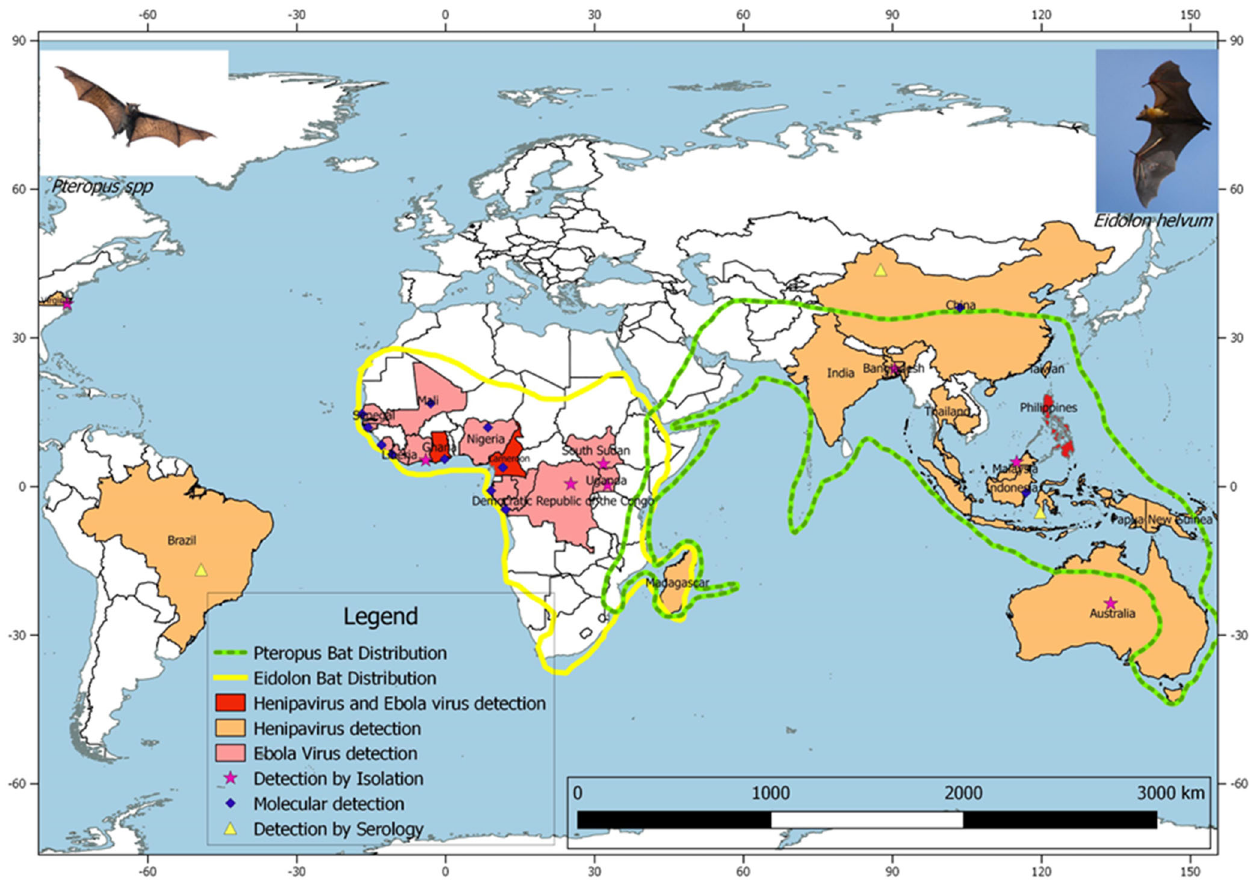
Fig. 1 Map showing the detection of Henipavirus and Ebola virus, and the distribution of their most likely reservoir host — the Pteropus and Eidolon bat genera. The green dotted line shows the distribution of Pteropus bats while the continuous yellow line shows distribution of the Eidolon bat species. Determination of the virus distribution is by detection of Viral RNA or antibodies against the viruses. The orange shade indicates countries where Henipavirus outbreaks have been recorded or henipaviruses detected in bats, while the pink shade indicates outbreaks or detection of Ebola virus. The red shade shows detection and/or outbreaks for both Ebola and different ratios of expression plasmid DNA for NiV M, F, G (Malaysia strain), HeV F, G (original Australian strain), and EBOV GP (Zaire strain), for a total of 30 µg of plasmid DNA per 15-cm dish (Fig. 2A). Incorporation of proteins onto the VLPs was con fi rmed using standard Western blot analysis. From the initial results of experiments such as that shown in Fig. 2A, we expanded the total µg of DNA used to 45 µg/15-cm dish and tried various DNA ratios (Fig. 2B). Transfection of cells with the DNA ratio 7:12:12:2:2:10 µg for NiV M, NiV F, HeV F, NiV G, HeV G, and EBOV GP, respectively, yielded the best protein incorporation into virions (Fig. 2B) and expression of the proteins in cell lysates (Fig. 2C), determined by fl uorescent Western blot analysis quanti fi cation. Individual protein blots with molecular weight markers for VLPs are shown in supplementary Fig. 11. We also determined the cell surface expression (CSE) levels for each glycoprotein by fl ow cytometry (Fig. 2D). Incorporation of the proteins onto VLPs was determined by fl ow virometry 34 (Fig. 2E). The results demonstrated that multiple glycoproteins can be found on the surfaces of viral particles of a single viral preparation. We demonstrated the presence and distribution of the glycoproteins on the surfaces of VLPs by electron microscopy. Figure 2F shows a TEM micrograph of VLPs and their spikes, which were not observed in negative control bald particle samples. These fi gures demonstrate that different immunogenic glycoproteins can be incorporated onto VLPs following transfection of HEK 293T cells.